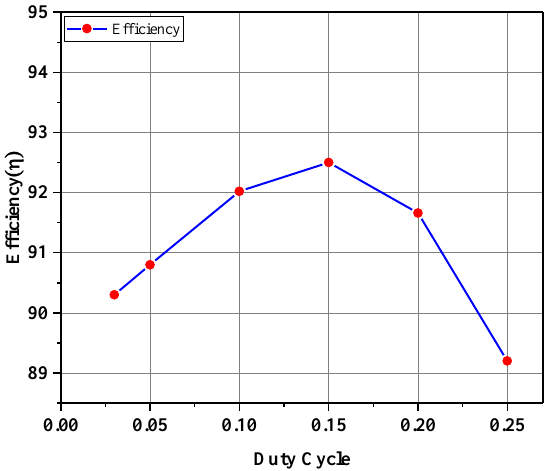
Figure 21. Experimental efficiency vs. duty cycle graph.